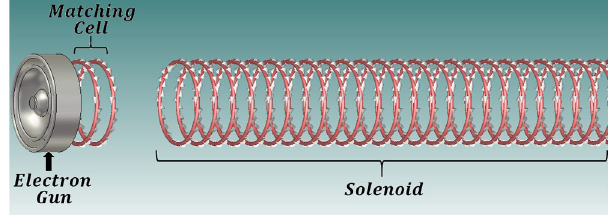
FIG. 10. The complex of the focusing channel. Two matching coils after the electron gun and 148 coils in the solenoidal structure. See also Fig.